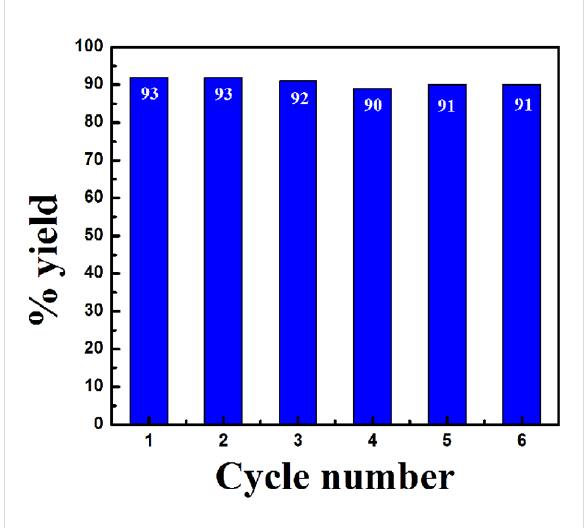
Figure 1: Recycling experiments of Ni/RGO-40 catalyst in C − S cross- coupling reaction between 4-iodoanisole and